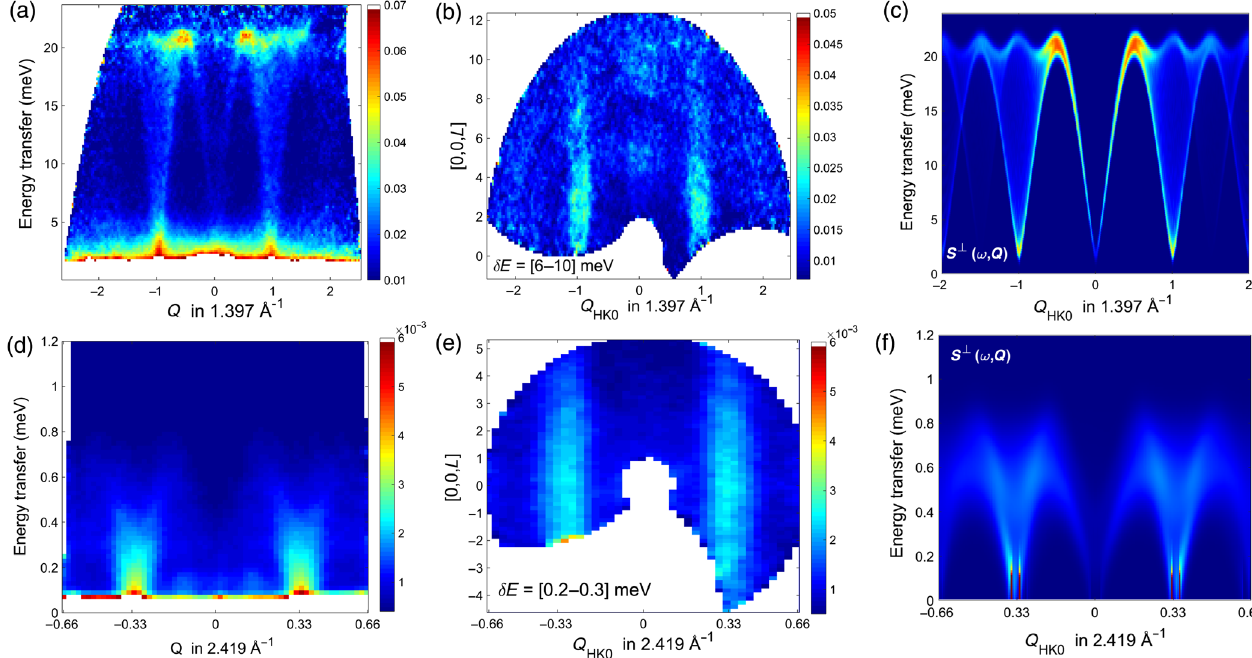
¼ 25 meV at the HYSPEC FIG. 11. (a) Energy-momentum slice of the inelastic neutron-scattering data measured with E i spectrometer. A spin-wave branch emerges from the (1,0,0) magnetic peak and extends to an energy transfer of approximately 22 meV. (b) Contour plot of the ( H , 0, L ) reciprocal plane for energy transfer integrated between 6 and 10 meV. The rod of scattering along the [0, 0, L ] direction indicates very weak coupling between magnetic layers. (c) Calculated spin-wave spectrum using a Heisenberg model that includes first- and second-neighbor in-plane exchange interactions [ J 1 ¼ 1 . 55 meV, J 2 ¼ − 0 . 45 ð 3 Þ meV] in the S ¼ 5 = 2 honeycomb lattice. (d) Low-energy magnetic excitations that develop around the magnetic peaks at ( 1 = 3 , 1 = 3 , 1) and ( 2 = 3 , 2 = 3 , 1). (e) 2D slice of momentum space corresponding to energy-transfer range 0.2 – 0.3 meV revealing the quasi-two-dimensional character of the excitations. (f) The calculated spin-wave spectrum of S ¼ 5 = 2 triangular lattice Heisenberg antiferromagnet characterized by ¼ 0 . 03 meV). The spectrum is averaged over nearest-neighbor exchange interactions ( J ¼ 0 . 08 meV) and an easy-axis anisotropy ( D t all in-plane Q directions to reproduce the experimental